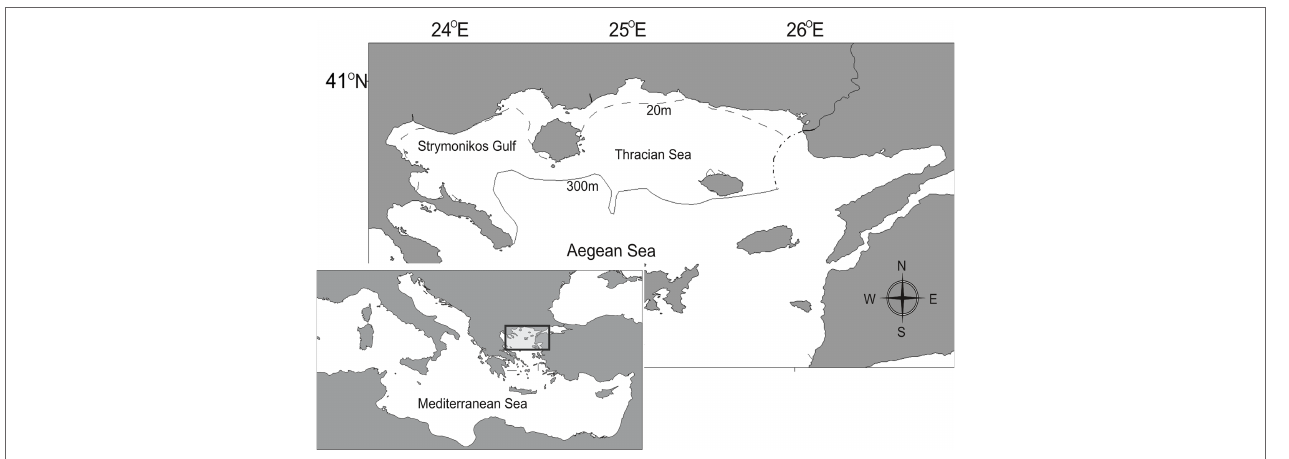
FIGURE 1 | The North Aegean Sea (Strymonikos Gulf and Thracian Sea) model